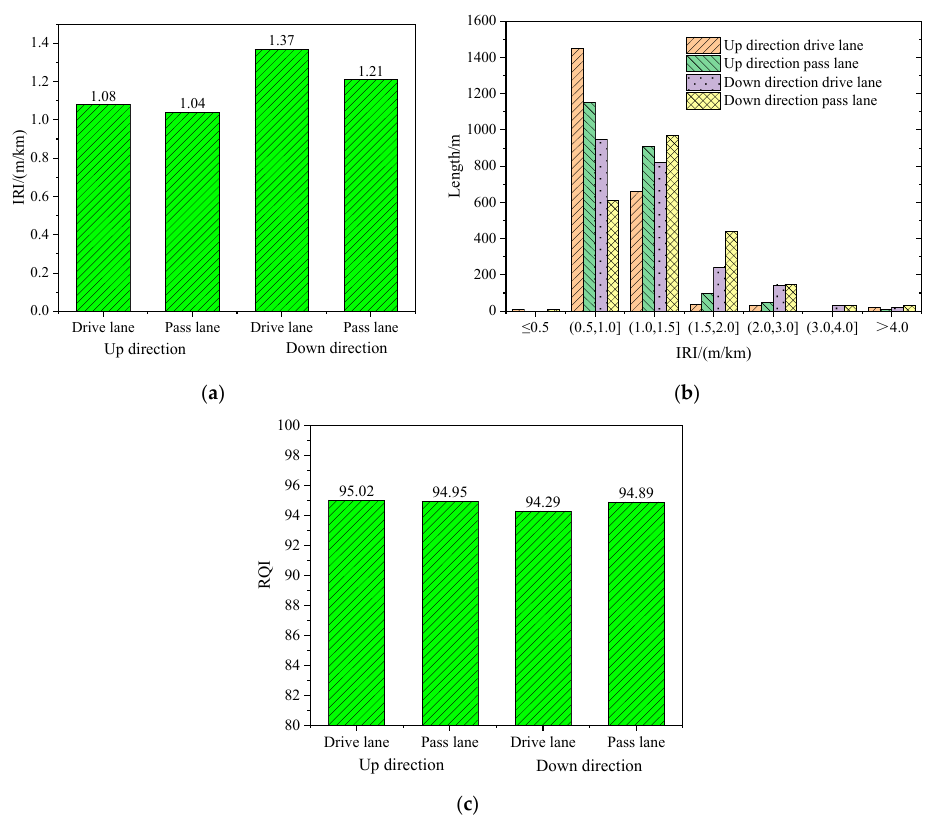
Figure 6. The roughness of XHMB pavement: ( a ) average IRI; ( b ) IRI distribution; ( c) average RQI.